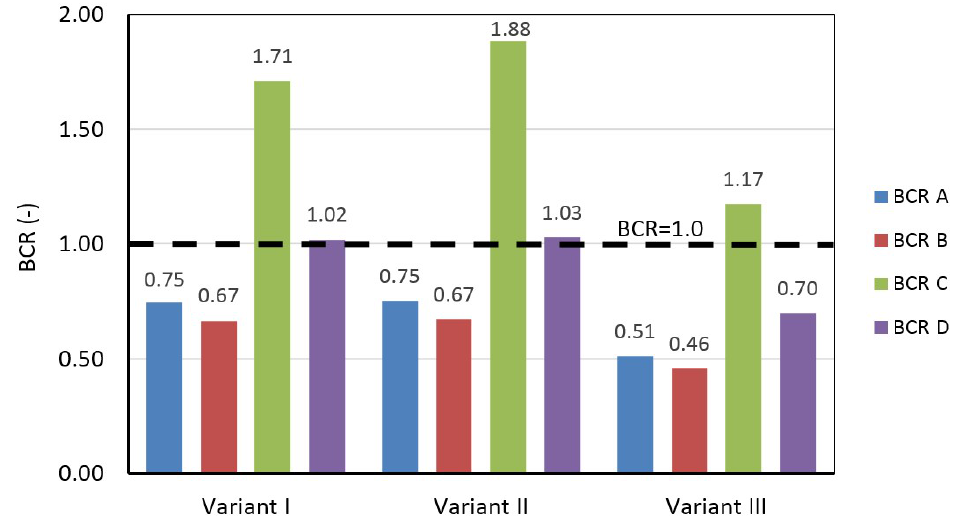
Figure 8. Calculated values of BCR (benefits–costs ratio ) indicator for all designed variants of sanitation network and various scenarios of assumed sewage fee payment, BCR = 1.0, threshold of prof- itability.